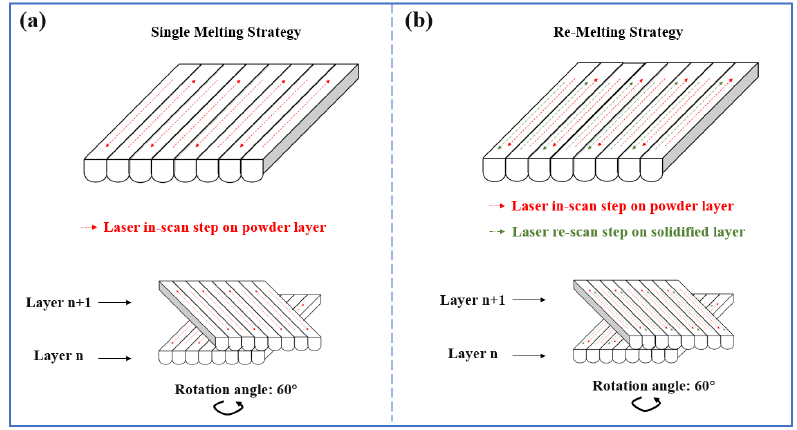
Figure 2. Schematic diagram of laser scanning strategies ( a ) SMS and ( b ) RMS.